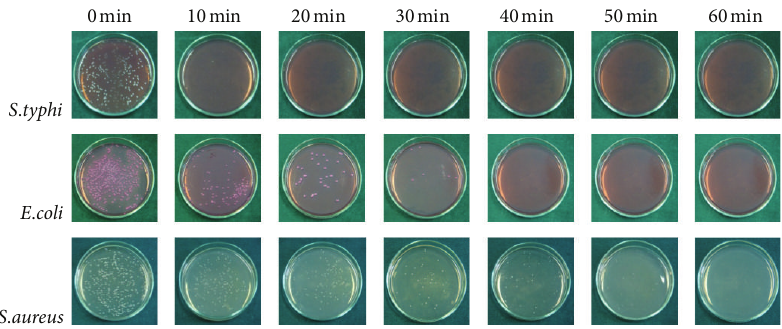
Figure 14: Growth of bacterial colonies on agar plates, after various treatment times. Glass fibers coated with 20N/3SnO 2 /TiO 2 were used to treat S. typhi, E. coli, and S. aureus under UV irradiation, and the number of colonies corresponds to remaining viable count of bacteria.